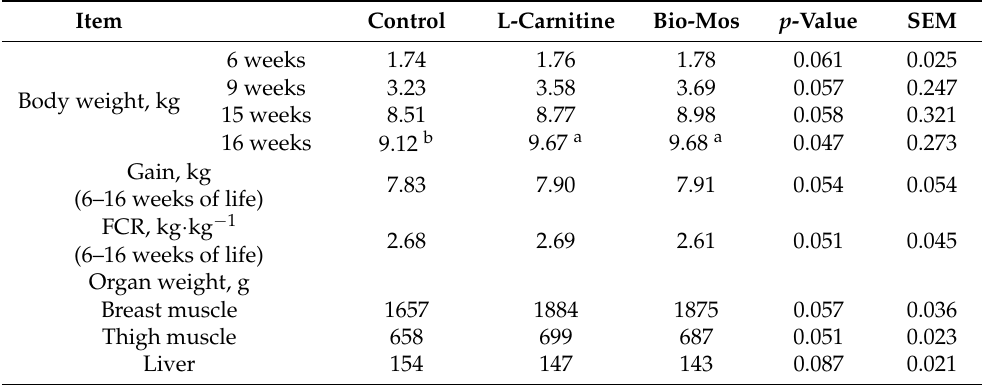
Table 4. Effect of L-carnitine and Bio-Mos on selected growth performance parameters and organ weight in female turkeys 1